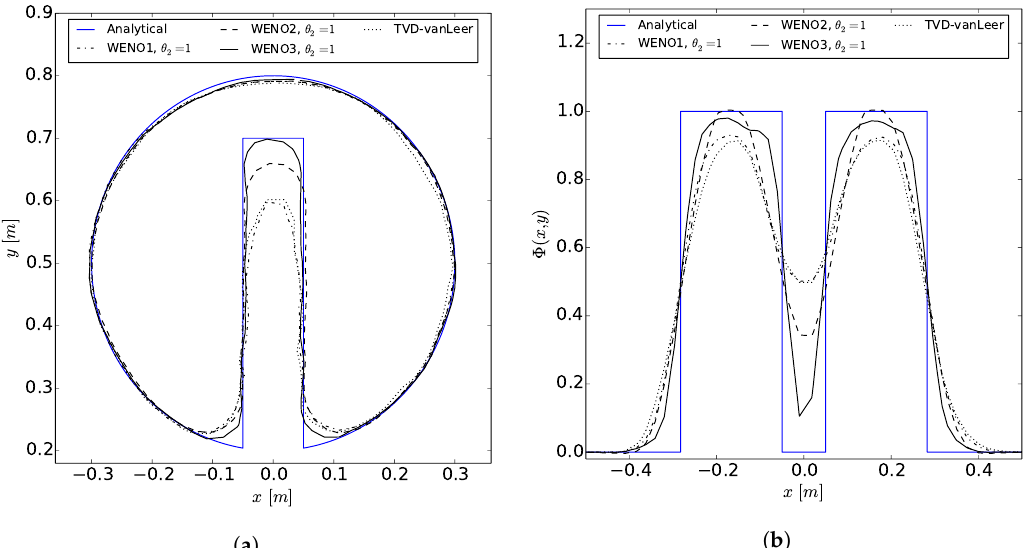
Figure 19. Results of convection schemes for Zalesak’s disk on 128 Φ = 0.5; ( b ) slice of the disk at y = 0.6 m.